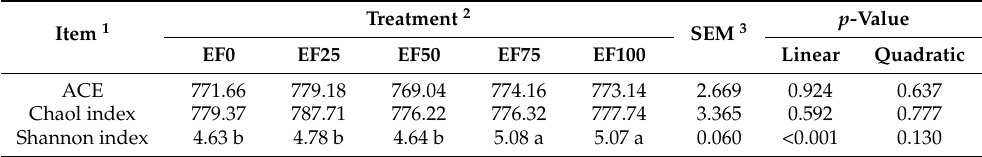
Table 4. The bacteria community richness in sheep rumen fermentation fluids medium with